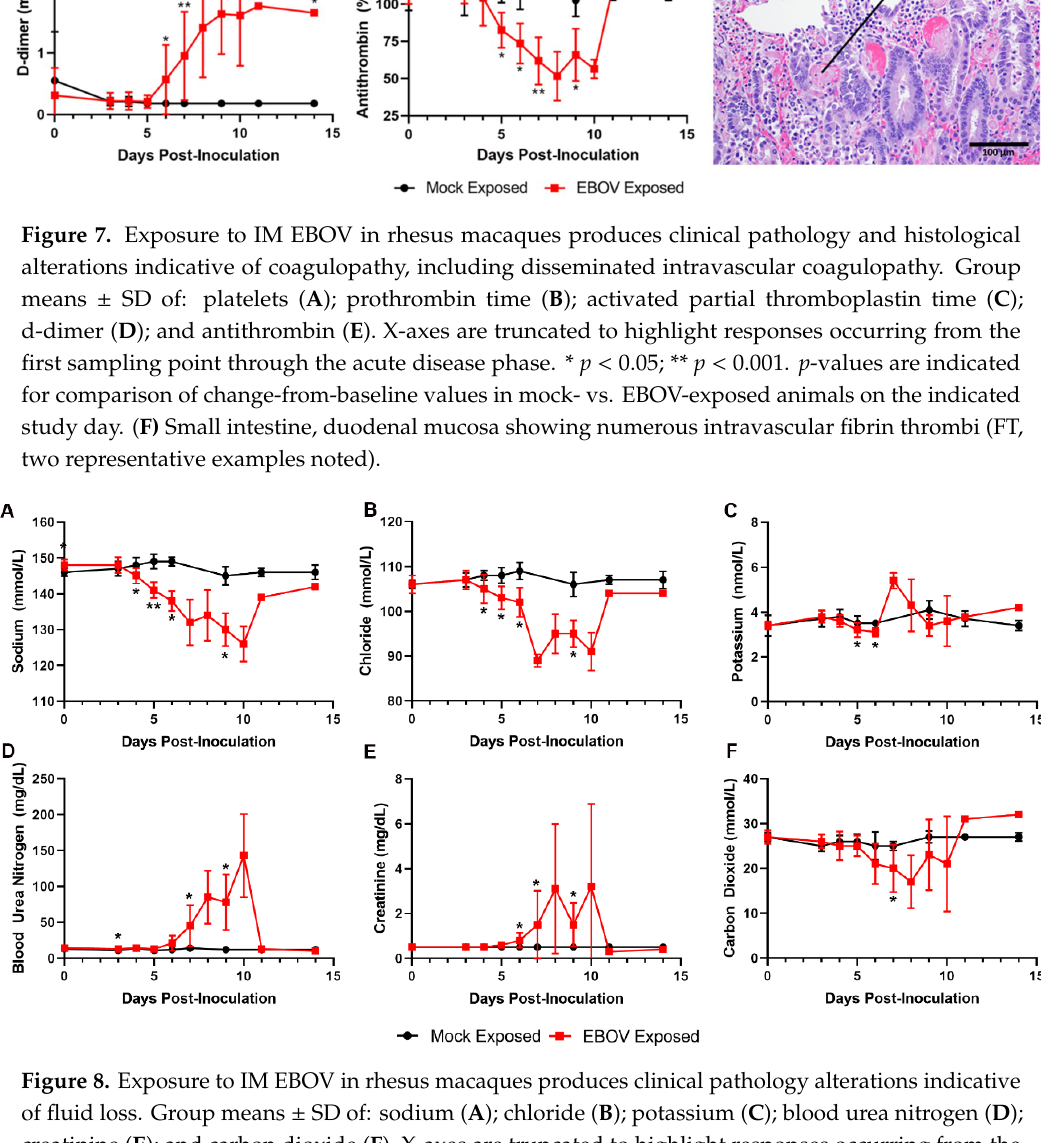
comparison of change-from-baseline values in mock- vs. EBOV-exposed animals on the indicated study day. ( F) Small intestine, duodenal mucosa showing numerous intravascular fibrin thrombi (FT, two representative examples noted).